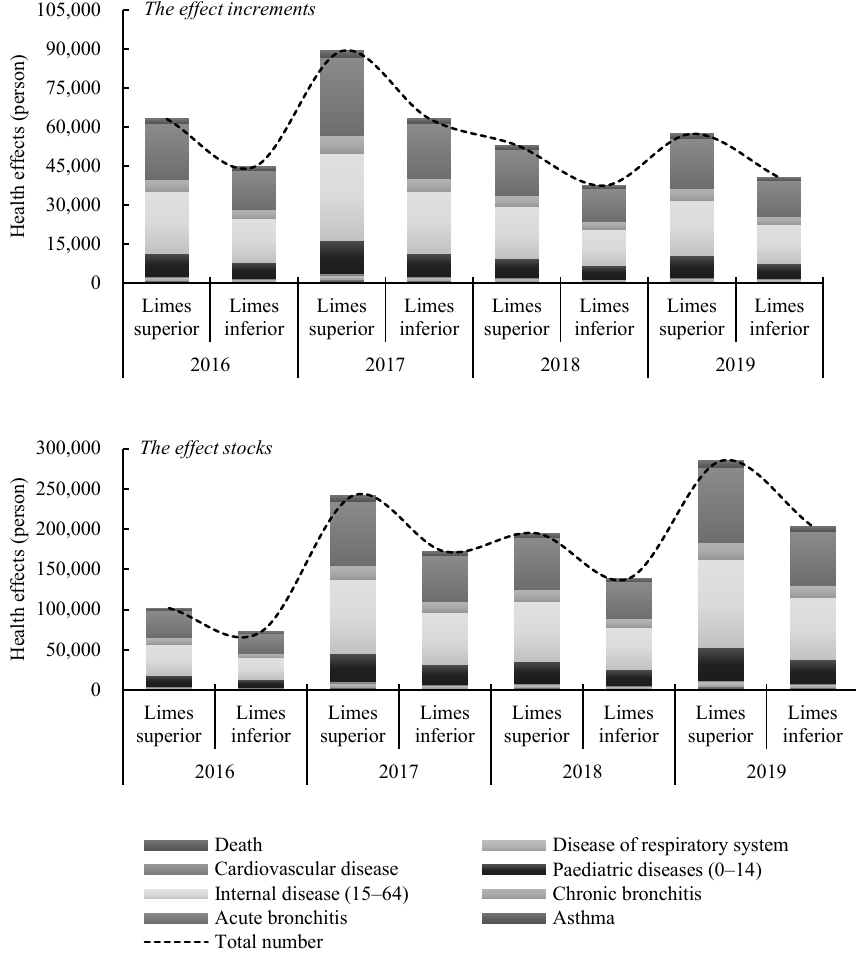
Figure 5. The health effects of NEV promotion in Beijing from 2016 to 2019.